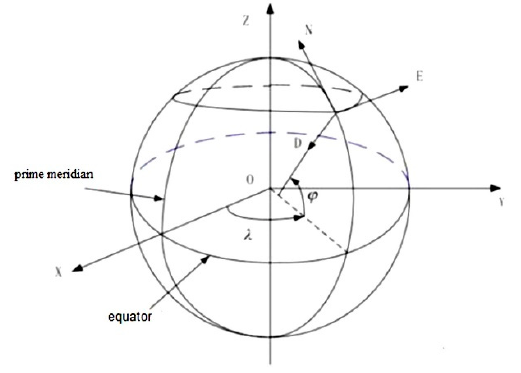
Figure 2. The geographic coordinate system (n system).